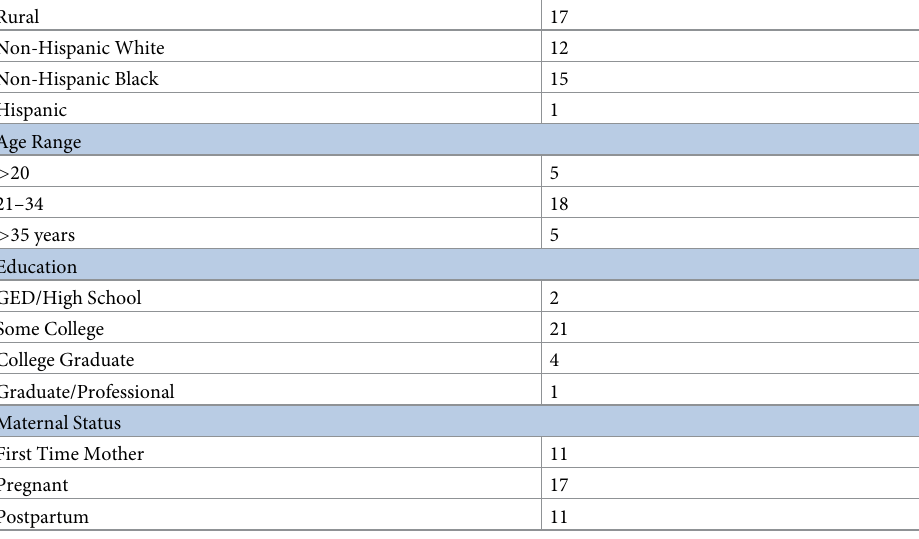
Table 1. Maternal demographics (n =